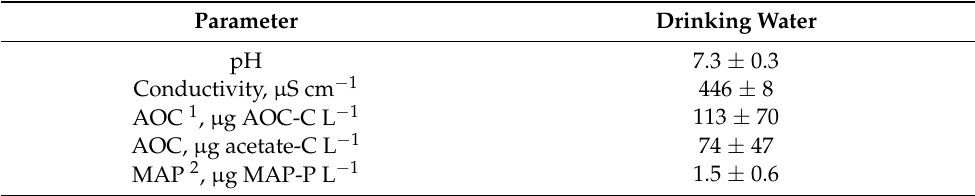
Table 1. Averages and standard deviations of physical-chemical properties of the test water ( n = 4).